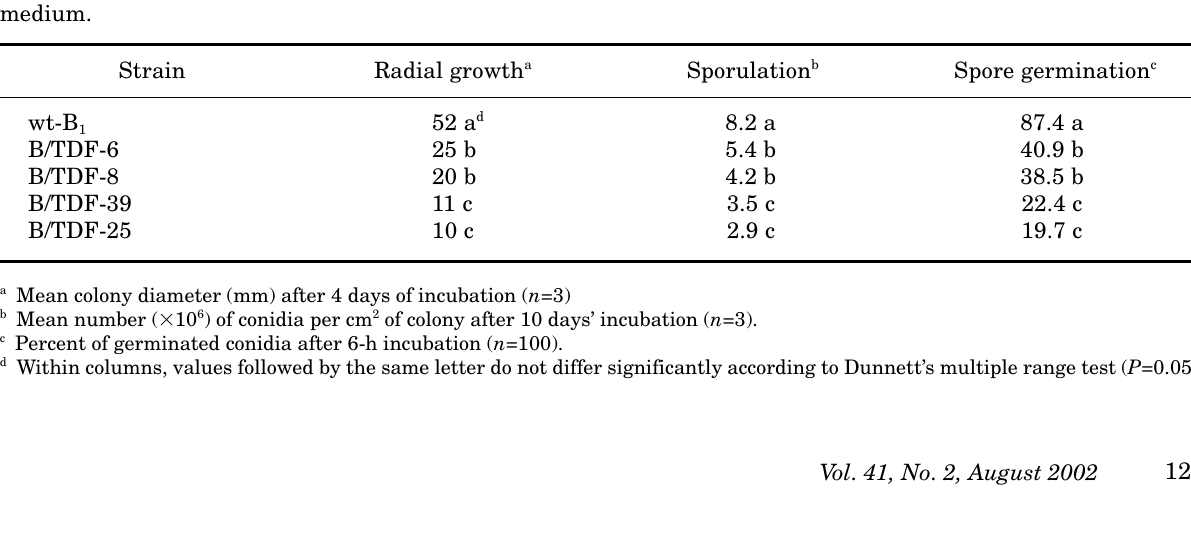
Table 5. Comparison of mutants (B/TDF-6, B/TDF-8, B/TDF-39, B/TDF-25) of Botrytis cinerea resistant to DMI- fungicides with their parental wild-type strain (wt-B